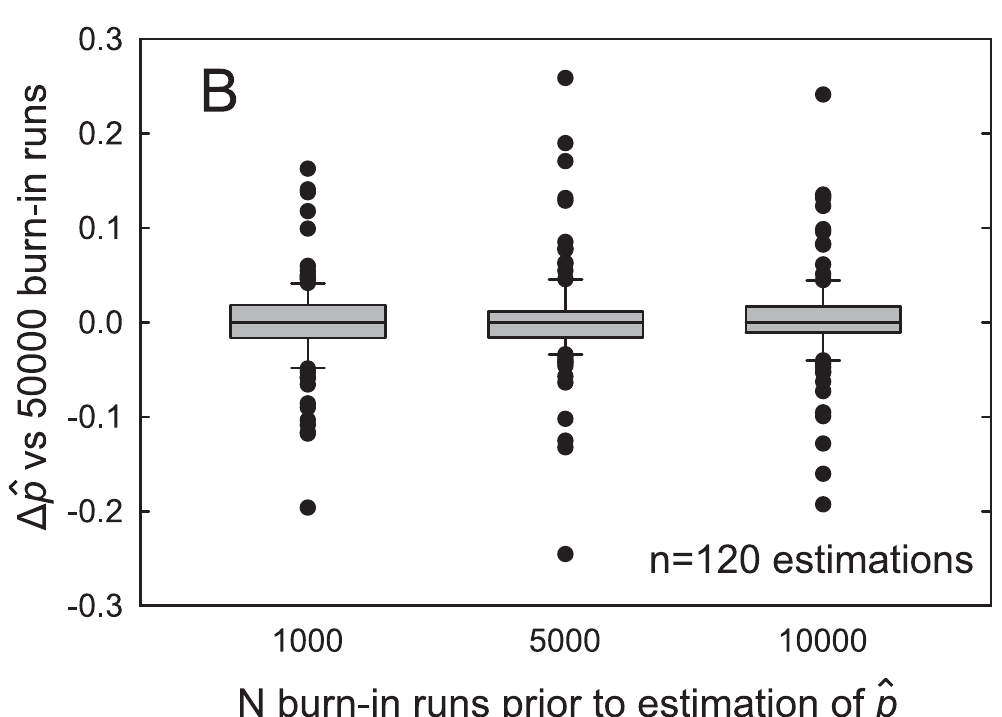
Fig 2. Reproducibility and effect of burn-in on BRACoD performance. Fig 2A: The inclusion probabilities from two separate BRACoD runs using the same set of simulated data are plotted against each other. Regression analysis showed good agreement between the runs: y = 0.994 × ^ p ^ (first run)– 0.0083; adjusted r 2 = 0.981. Fig 2B: Box and whisker plot showing difference in ^ p ^ values for various numbers of burn-in runs vs 50000 burn-in runs as reference. Values for 1000, 5000, and 10000 burn-in runs were not significantly different from that for 50000 burn-in